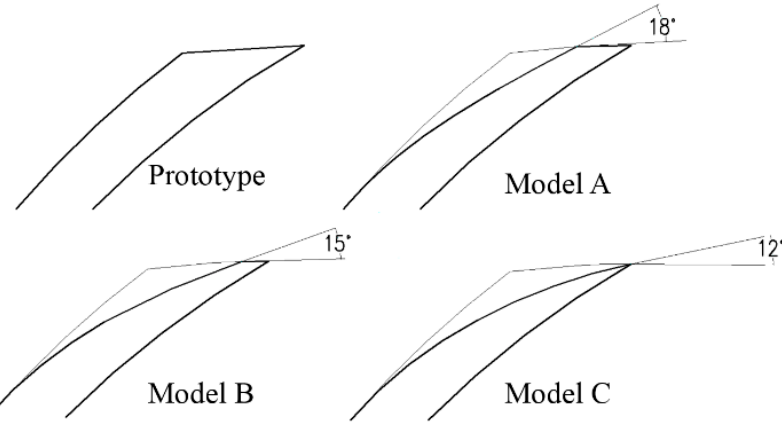
Figure 4. Modifications to the blade trailing